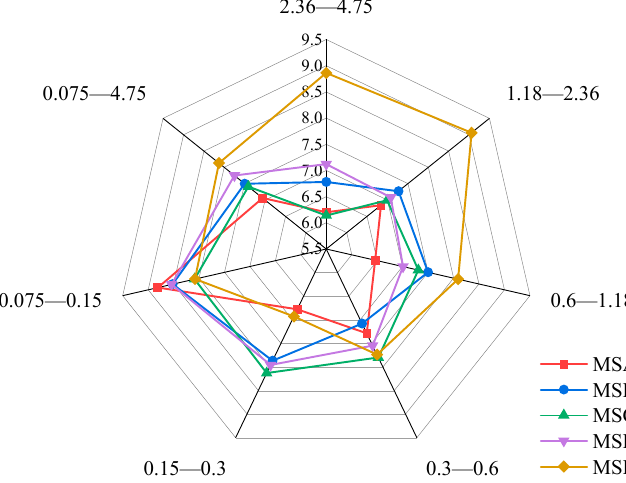
Figure 10. Mean values of form2Ds of five manufactured sands.